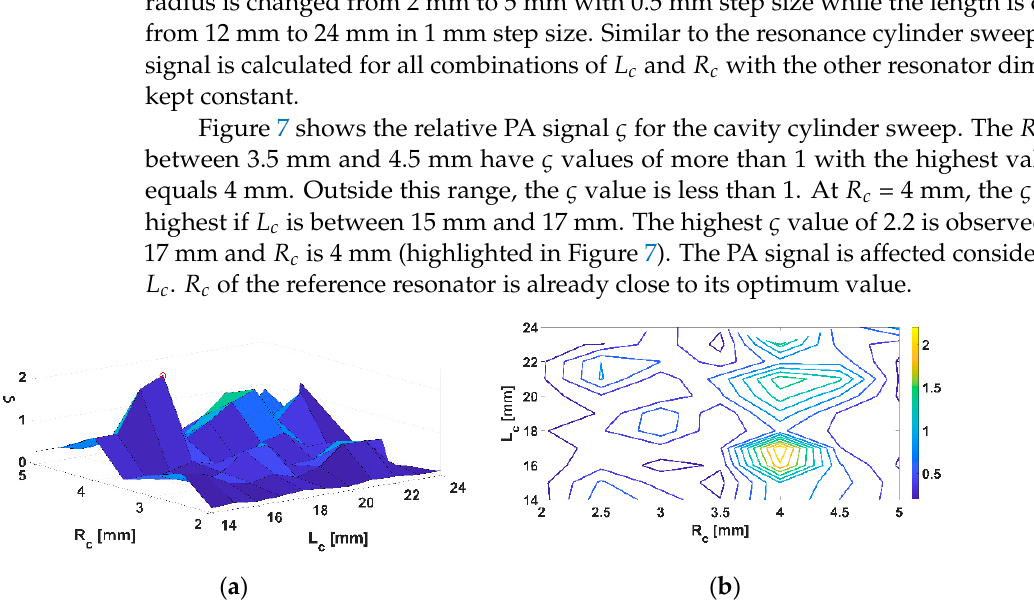
Figure 7. Relative PA signal of the coarse cavity cylinder sweep (a) along with a contour plot (b). The color scale gives the values of 𝜍 . The peak highlighted in the left plot is the region with the highest relative PA signal.